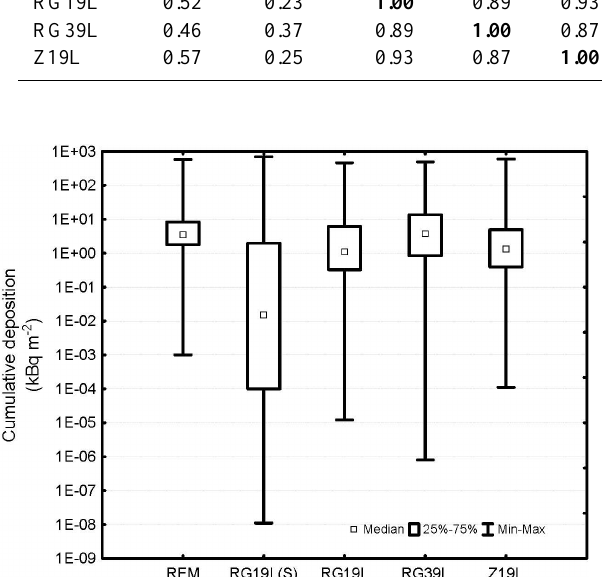
Fig. 15. Box & Whisker plots of the cumulative total deposition of 137 Cs obtained from the REM database and from the simulations using all the available versions of the model (RG19L(S), RG19L, RG39L and Z19L for 1986. The plot depicts the smallest observa- tion (sample minimum), lower quartile, median, upper quartile and the largest observation (sample maximum) ( N =